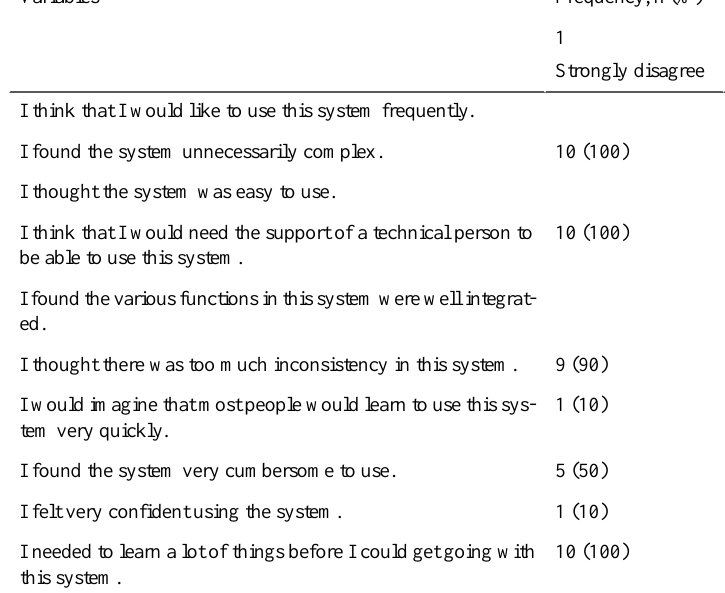
Table 4. Frequency distribution of the